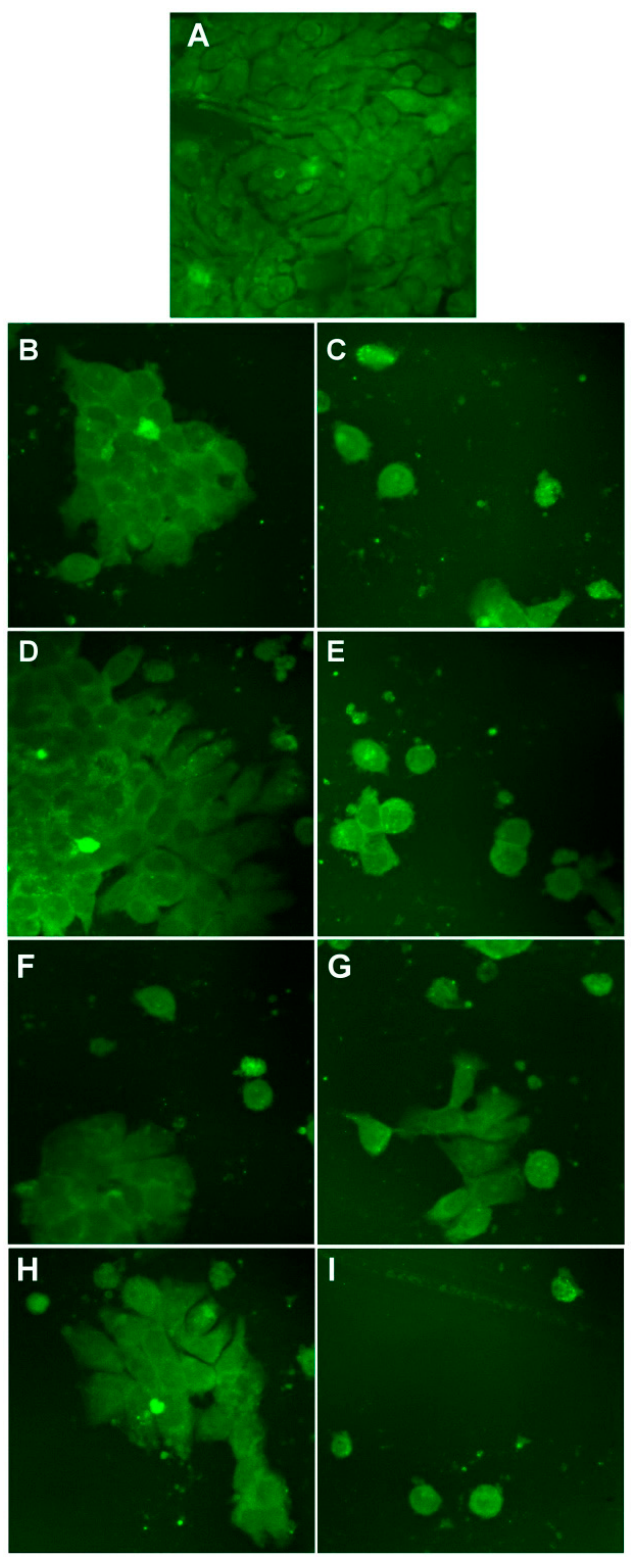
Figure 15. Morphology of control HepG2 cells ( A ) and cells after treatment with 6.4 µM and 51.1 µM of P3 ( B , C ), P4 ( D , E ), P5 ( F , G ), and P6 ( H , I ). Images are obtained with a 40× objective and in an epifluorescence mode.